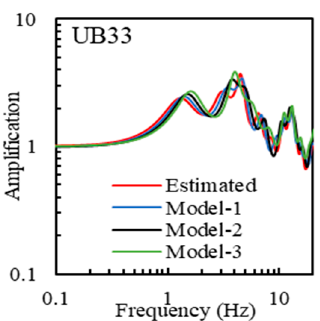
Table 5. The parameters for sensitivity analysis (UB33).